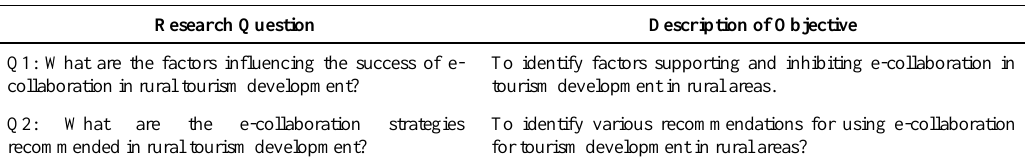
Table 1. Research